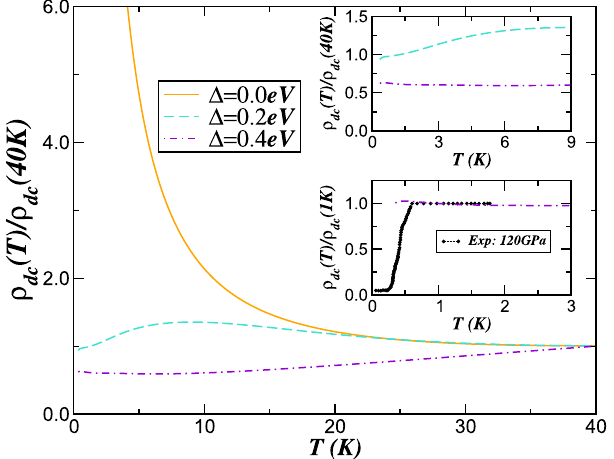
Figure 6. Electrical resistivity of solid O 2 at high pressures. Main panel: Normal state resistivity versus temperature (normalized to ρ (40 K )), showing the metal-insulator transition with increasing the orbital “Zeeman” field Δ . Inset shows resistivity at very low temperatures: Observed features at low- T are well reproduced by strong Coulomb correlations U , U ′ and Δ = 0.4 eV. Notice that results with small Δ value deviates from observation of constant ρ ( T ) at 120 GPa in experiment 9 . It is possible that a detailed